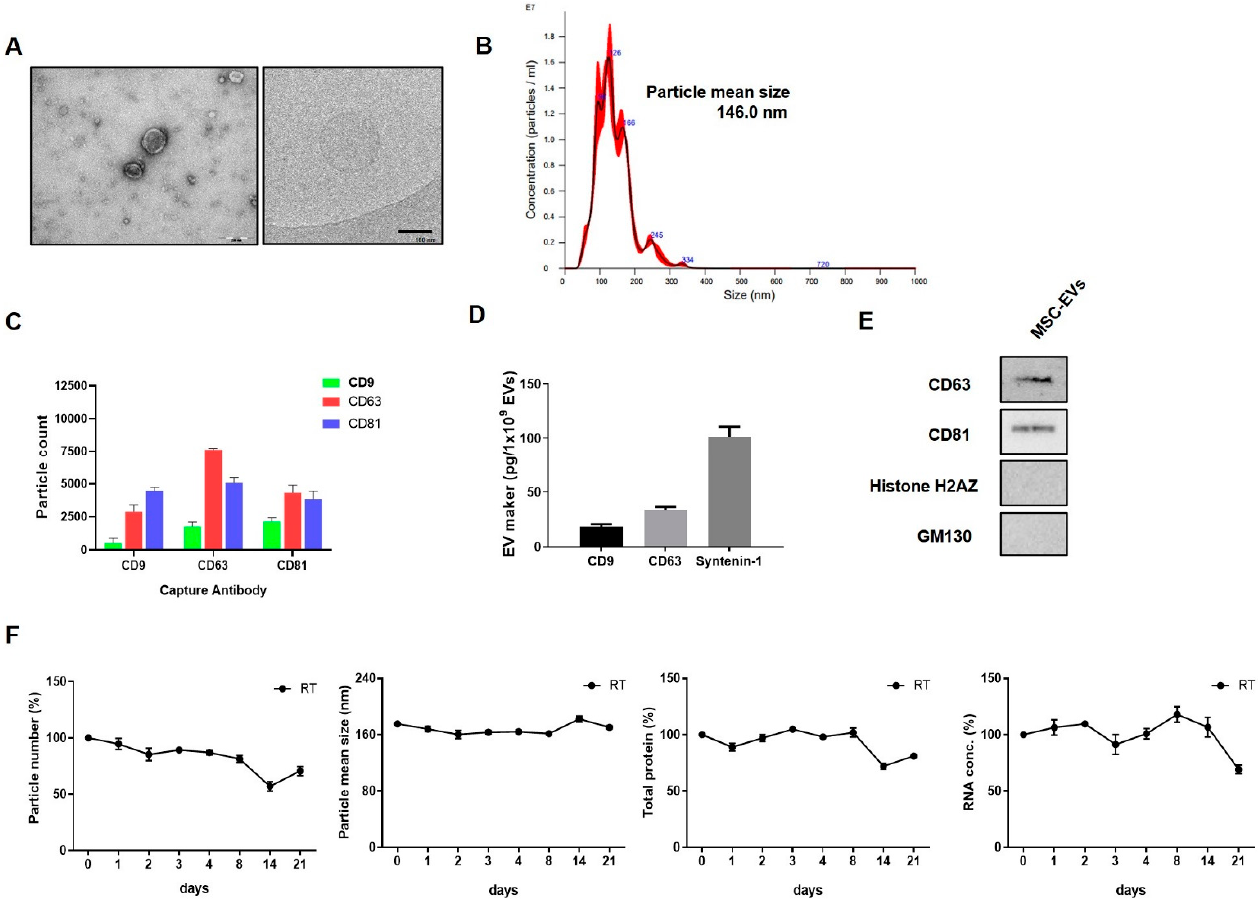
Figure 1. Characterization of extracellular vesicles (EVs) obtained from 3D culture system. ( A ) EVs imaged using electron microscopy (TEM and Cryo-EM); ( B ) histogram representing the size distributions and concentrations of the EVs using NanoSight. ( C ) The tetraspanins, including CD9, CD63, CD81, using Exoview analysis; and ( D , E ) EV positive markers, including CD63, CD81, syntenin-1 (enzyme-linked immunosorbent assay, ELISA) and EV negative markers, including histone H2A.Z and GM130 (Western blot). ( F ) Change in EVs according to storage period at RT.